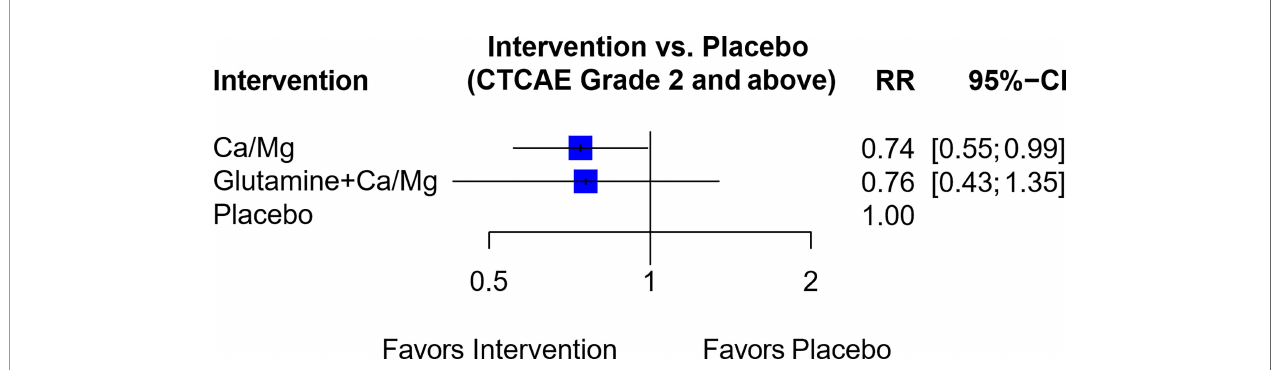
FIGURE 7 | Forest plot for network analysis comparing Glutamine + Ca/Mg, Ca/Mg and placebo on the risk of OIPN of CTCAE grade ≥ 2. Risk ratio comparing combination therapy “ glutamine + Ca/Mg ” against placebo was derived indirectly from network meta-analysis, while the risk ratio comparing Ca/Mg against placebo was derived directly from 6 trials that conducted the